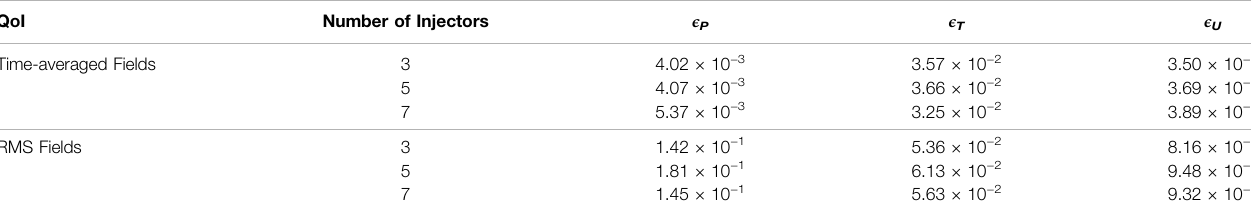
TABLE 5 | Comparisons of the errors in predicting time-averaged and RMS fi elds of pressure ( P ), temperature( T ), and axial velocity ( U ) corresponding to Figures 10D-E using the all-adaptive-basis-ROM framework for the multi-injector combustor. QoI Number of